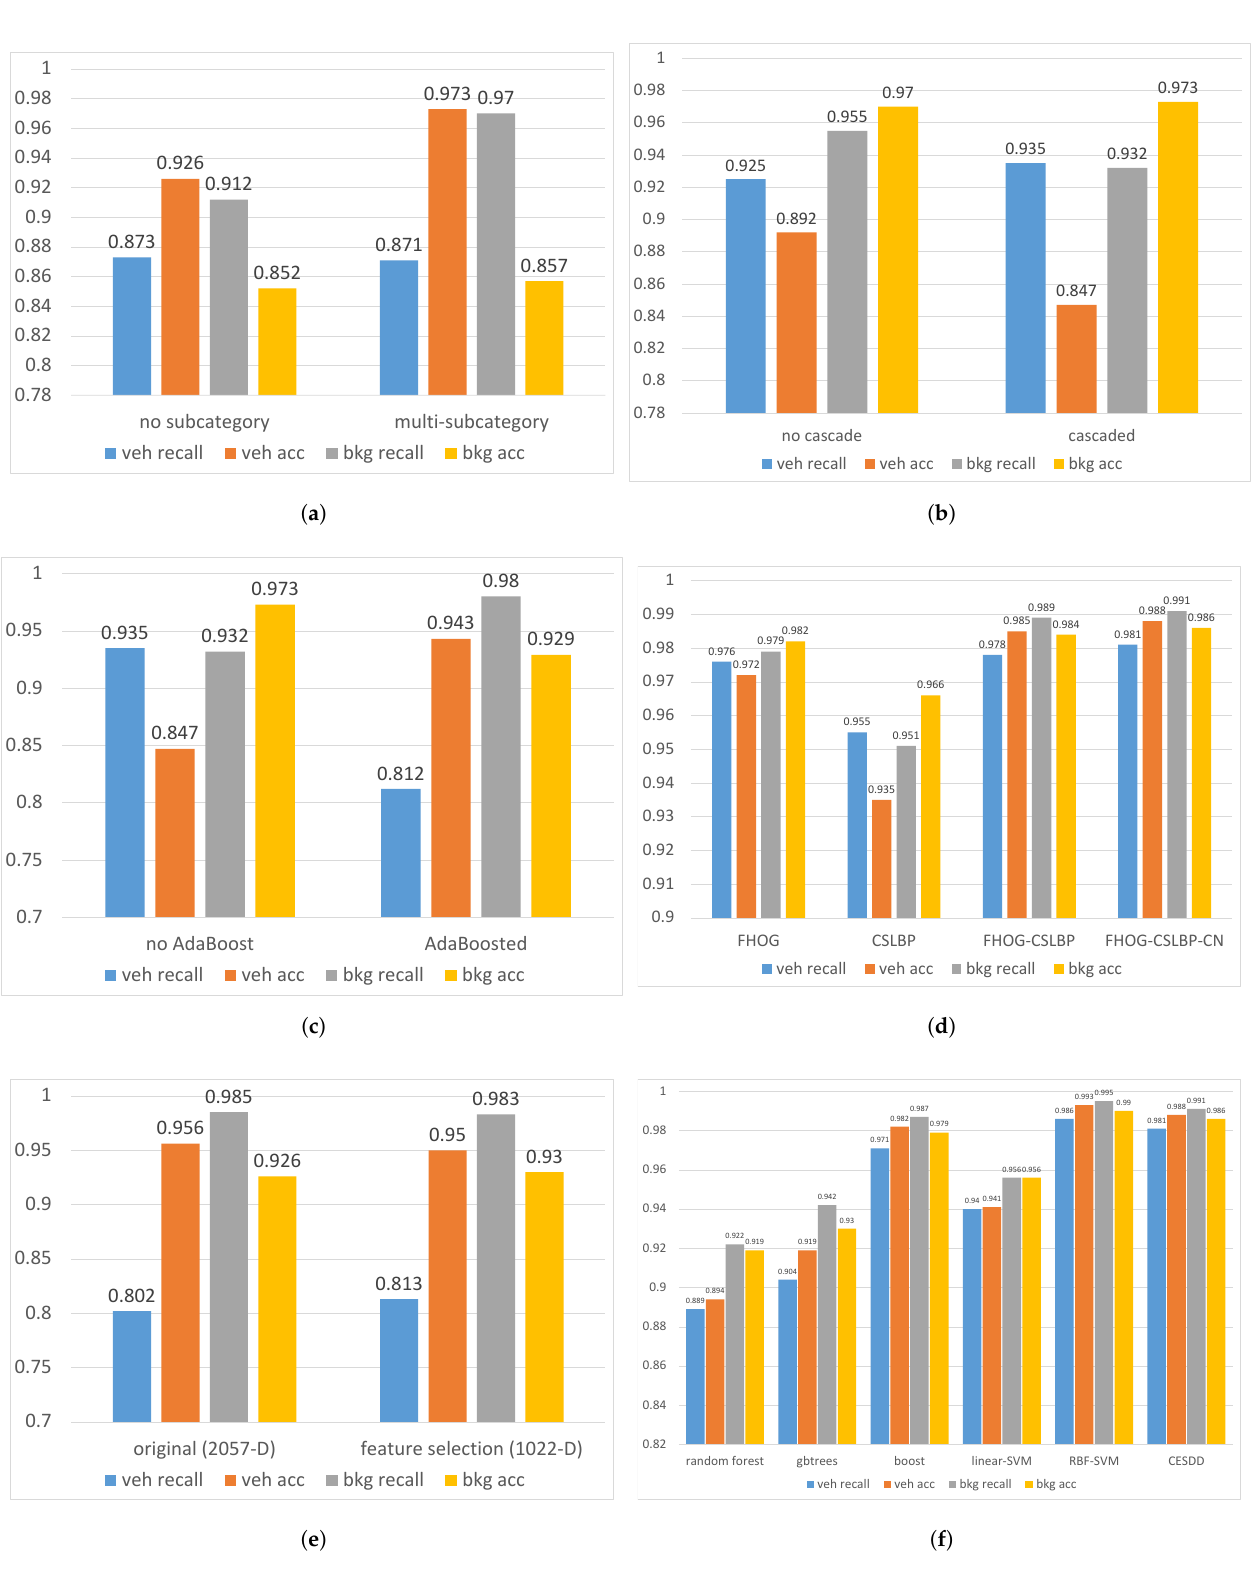
Figure 6. Quantitative ablation evaluation results of CESDD classifier on KITTI2017 . ( a ) multiple subcategories vs. no subcategory; ( b ) with cascade vs. without cascade; ( c ) with AdaBoost vs. without AdaBoost; ( d ) comparison of features; ( e ) with vs. without feature selection; ( f ) CESDD classifier vs. other